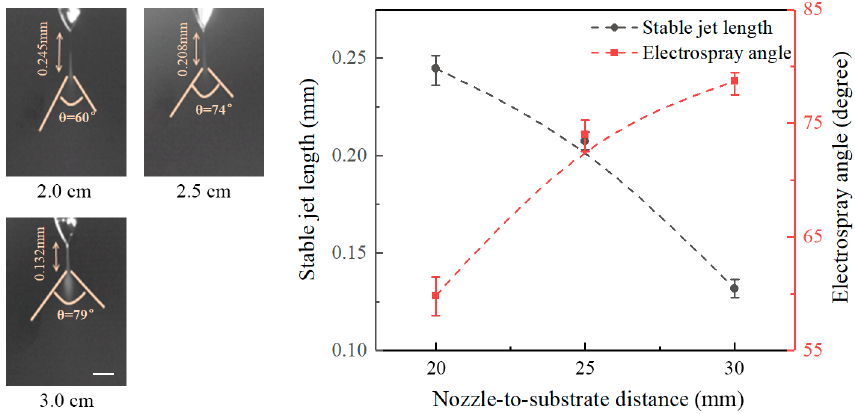
Figure 4. Effect of nozzle-to-substrate distance on the stable jet length and electrospray angle. The applied voltage is 6 kV and the flow rate is 20 μ L/h. Scale bar: 0.1 mm.